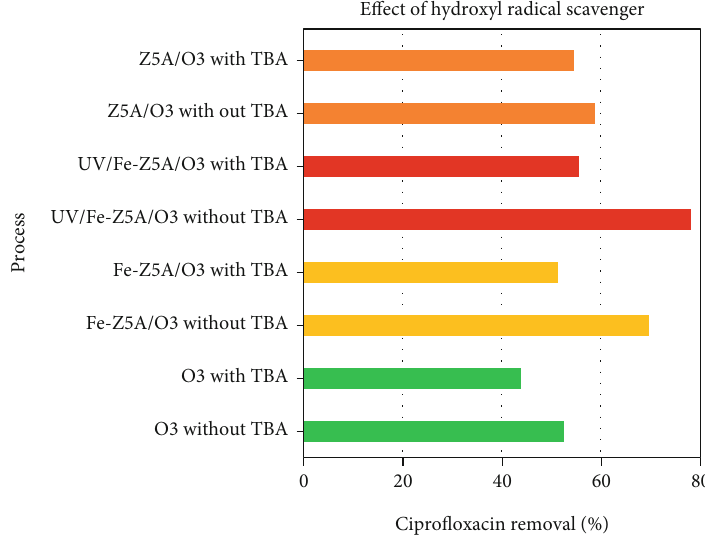
Figure 10: TBA e ff ect on cipro fl oxacin removal for O ppm ; pH = 6 : 5 ± 0 : 2 ; O